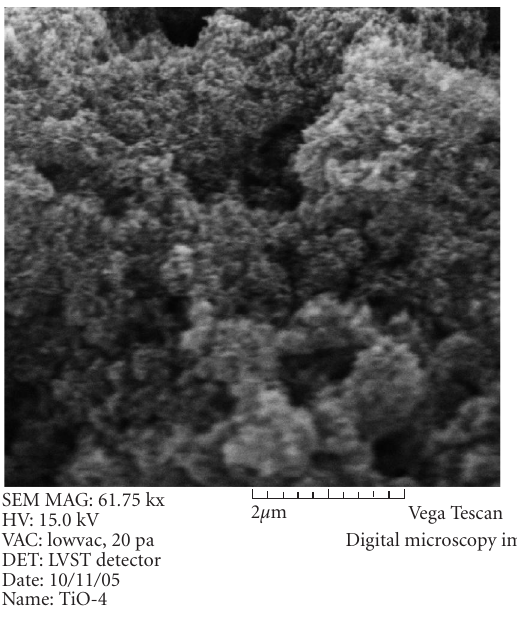
Figure 1: Electron micrograph (scale shown on figure) of the sur- face top layer of a membrane ( PHOTOPERM (cid:2) BIT/313 ) prepared by photoinitiated grafting and graft-polymerisation onto a nonwo- ven polypropylene tissue of 250 gm − 2 of a prepolymeric blend con- taining 30 ± 3wt% of titanium dioxide (P25 by Degussa, Germany) in the presence of proprietary photoinitiating and photosensitising